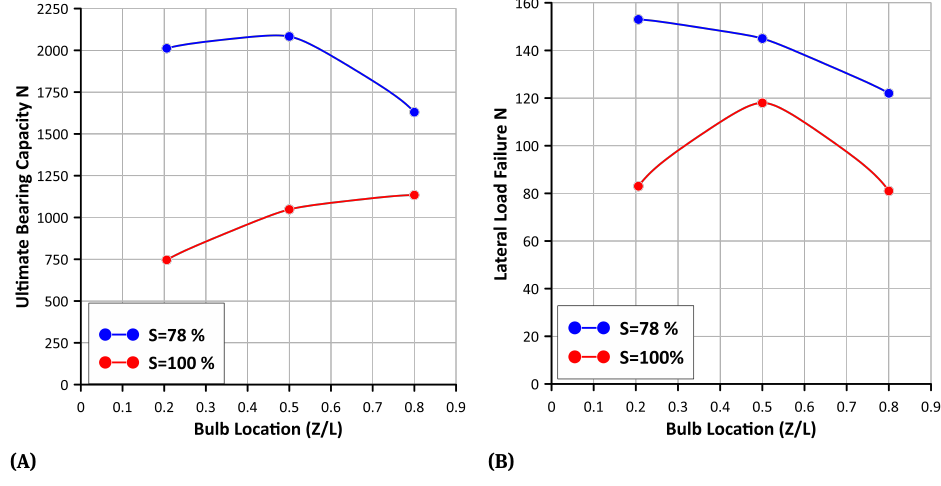
Figure 8: Relation between bulb location and (A) Vertical load (B) Lateral